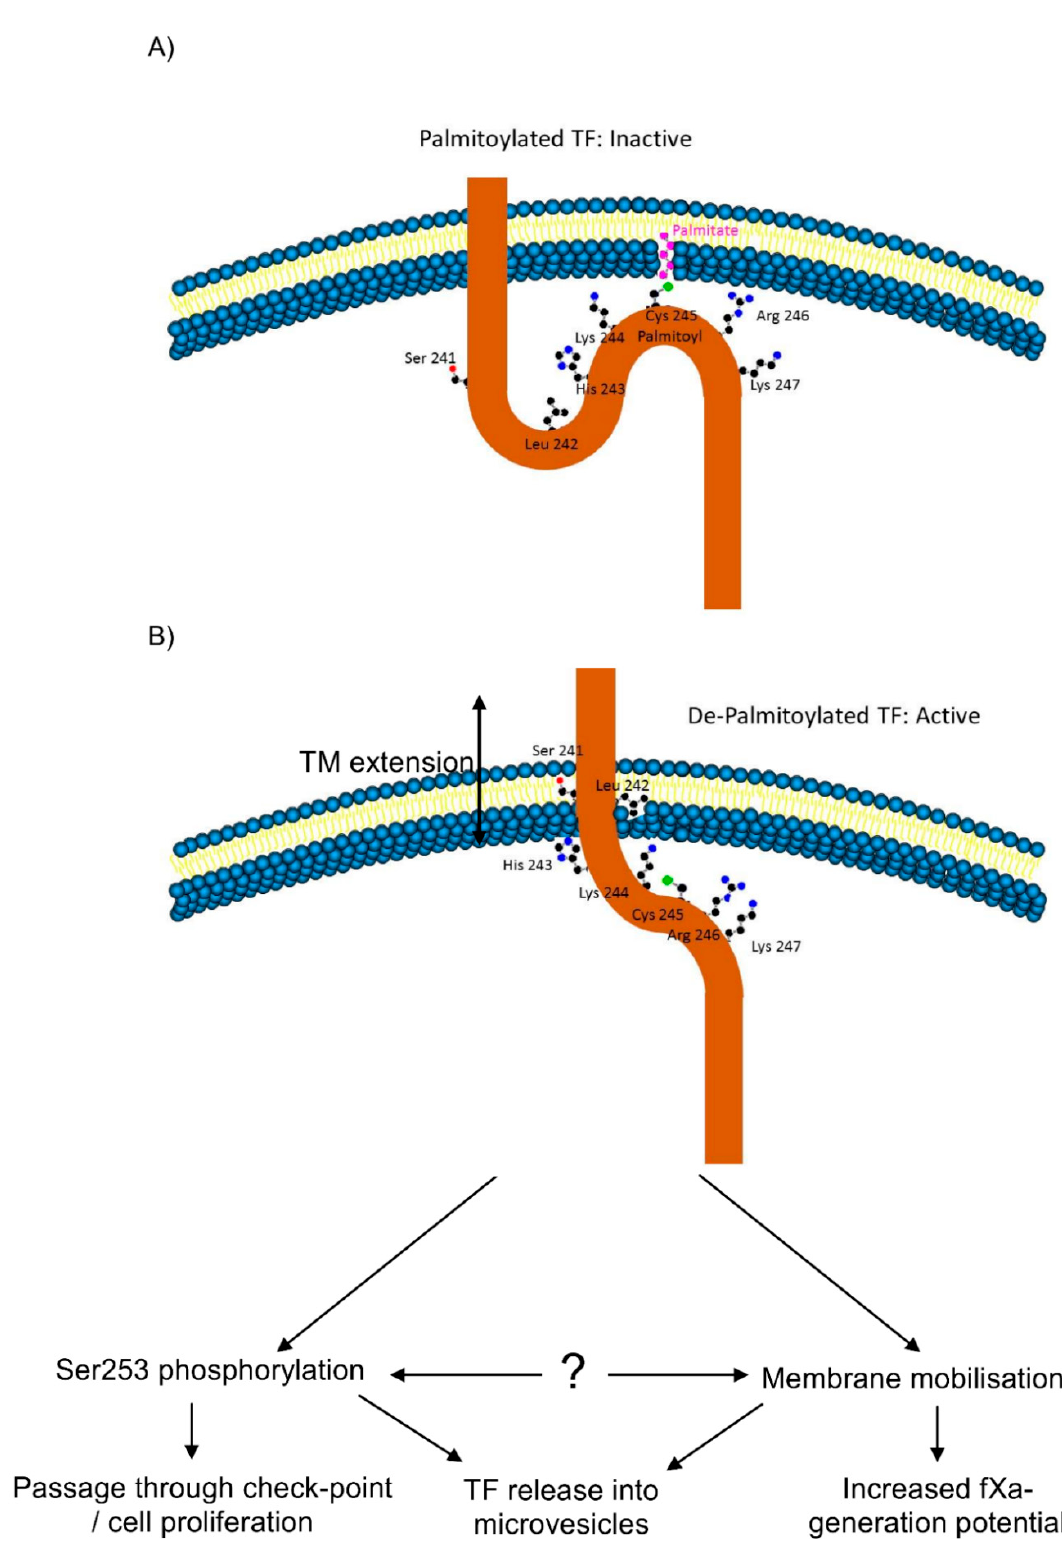
Figure 7. Schematic representation of the outcome of TF de-palmitoylation on the transmembrane and cytoplasmic domains. ( A ) Palmitoylation of Cys245 retains the transmembrane-cytoplasmic interface-region within the cytoplasm. ( B ) De-palmitoylation of TF permits Ser241-Leu242 to be incorporated into the cell membrane elongating the transmembrane domain from 21 to 23 amino acids.